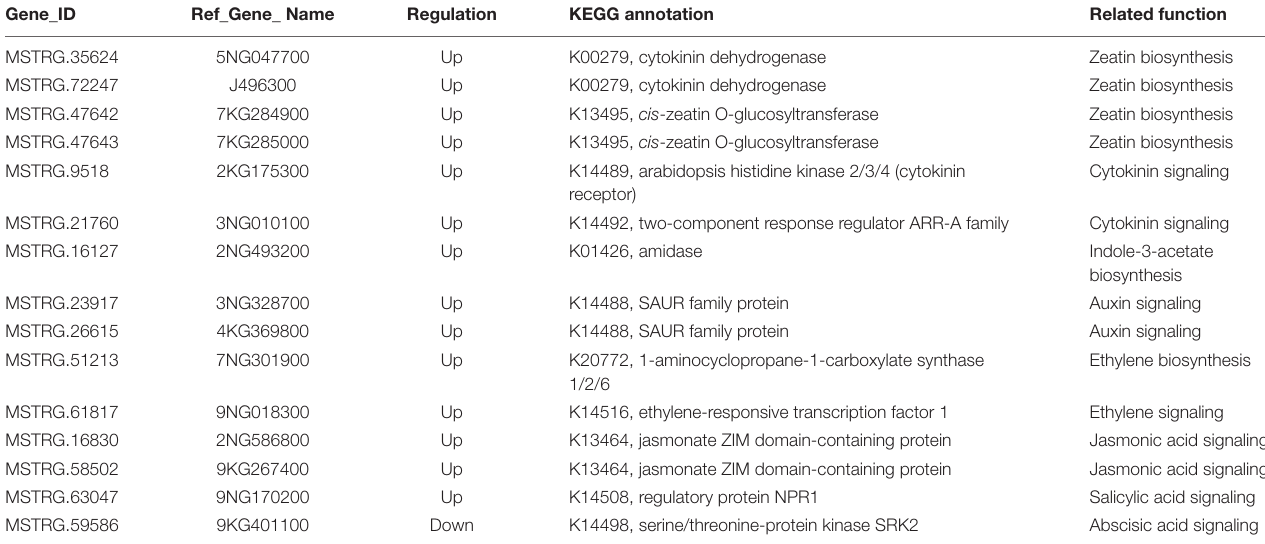
FIGURE 5 | Cluster of Orthologous Groups database of proteins (COG) functional classification of the predicted-DEGs. A total of 214 DEGs were annotated and assigned to 21 functional clusters. The x -axis indicates the COG categories as listed on the right, and y -axis means the number of genes. TABLE 3 | Kyoto Encyclopedia of Genes and Genomes (KEGG) enriched DEGs associated with hormone biosynthesis and